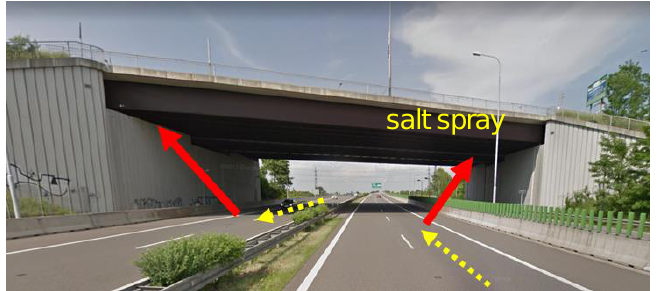
Figure 1. Tunnel-like conditions under the bridge (road bridge over highway D1 in the city of Ostrava, Czech Republic).